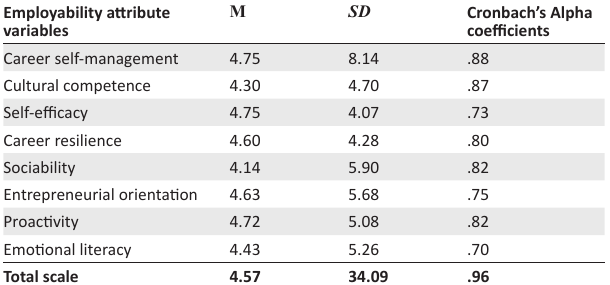
TABLE 3: Means and standard deviations of the Employability Attributes Scale ( N = 304).